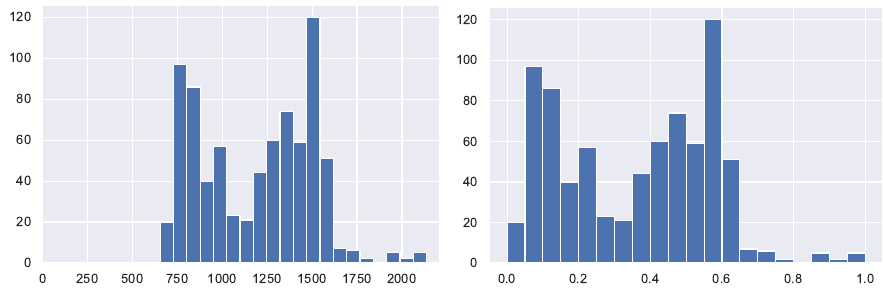
Figure 3. Histogram of daily consumption, before and after the extended standardization by rows.